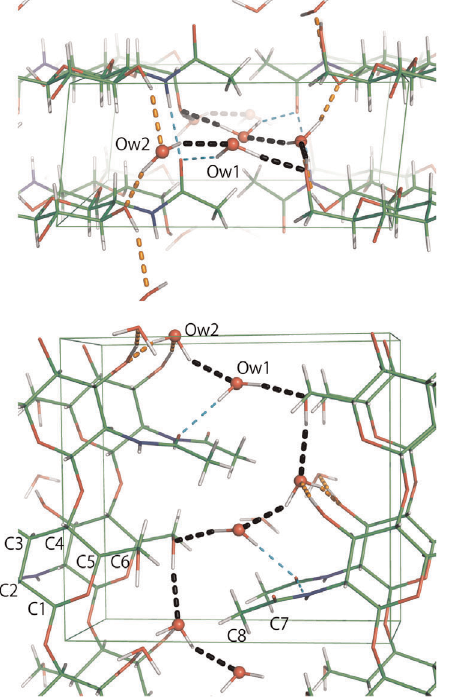
Figure 2. Final structure model and hydrogen bond networks of dihydrate b -chitin. It is seen along the chain direction and ab projection.